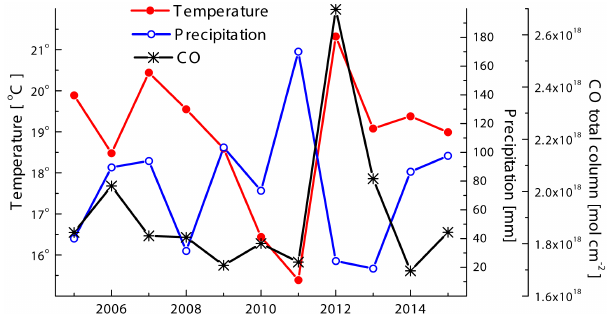
Figure 2. The map of forest fires over Siberia in the period from 19 to 28 July 2012 (http://lance-modis.eosdis.nasa.gov/cgi-bin/ imagery/firemaps.cgi). The Tomsk region (56–61 ◦ N; 75–88 ◦ E) is highlighted by a